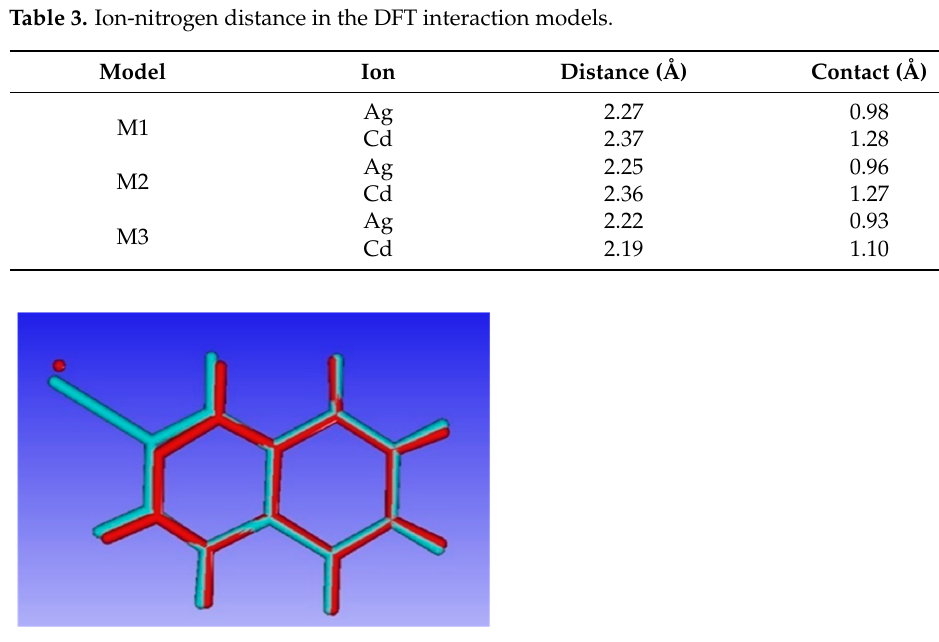
Figure 9. “Pyridinic” interaction model M1. Ag + : cyan; Cd 2+ : red.